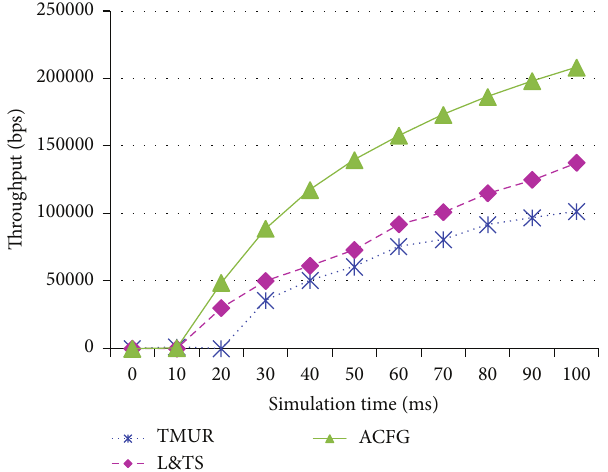
Figure 13: Throughput of TMUR, L&TS, and